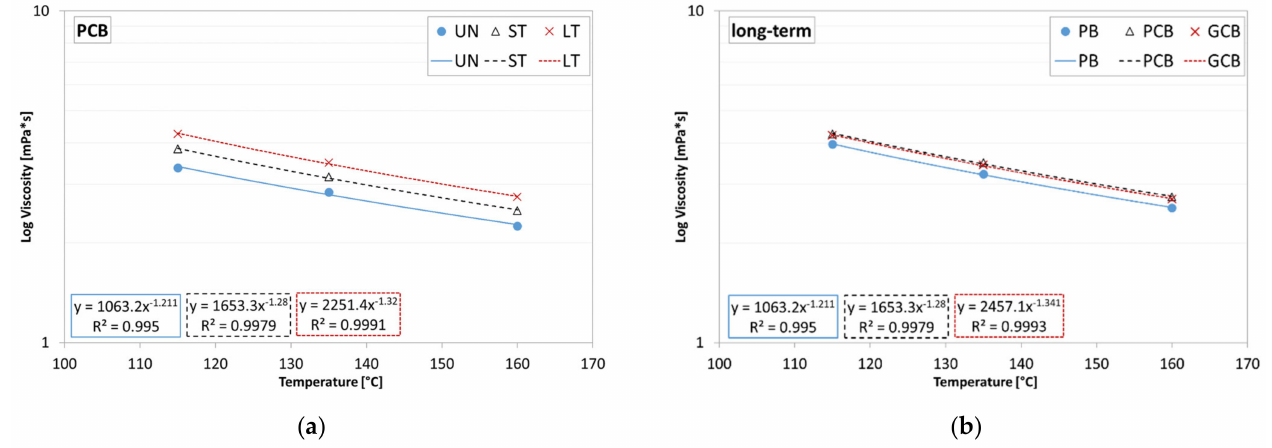
Figure 10. Average results of viscosity: ( a ) different aging conditions of blend PCB; ( b ) different blends under long-term aging